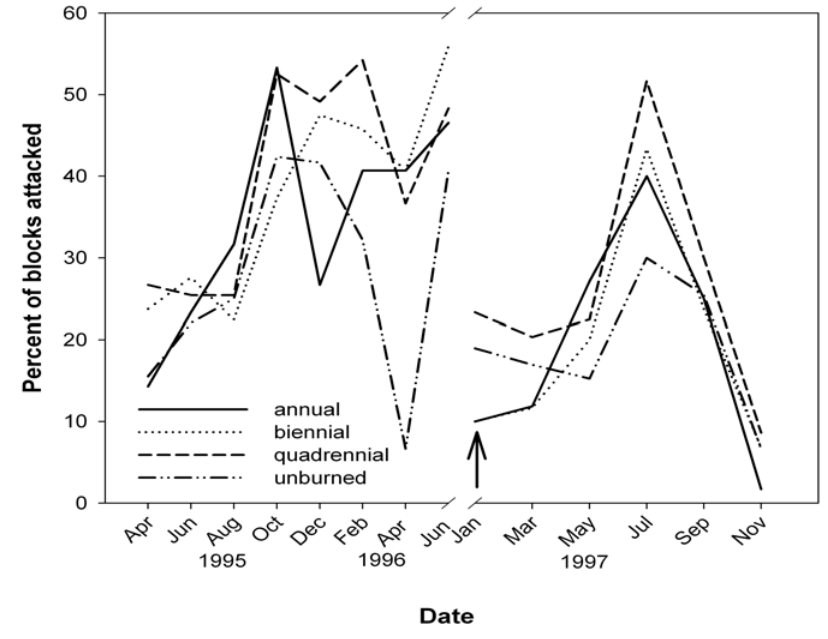
Figure 3. Overall percentage of wooden blocks infested by termites at each burn frequency. The original blocks were replaced in November 1996. The x-axis break is used to separate the two sets of blocks and the arrow at January 1997 indicates the first reading taken from this second set of blocks. Mantel-Haenzel Chi-Square statistics were calculated separately for each sampling period. Significant results were obtained only for April 1996 (see